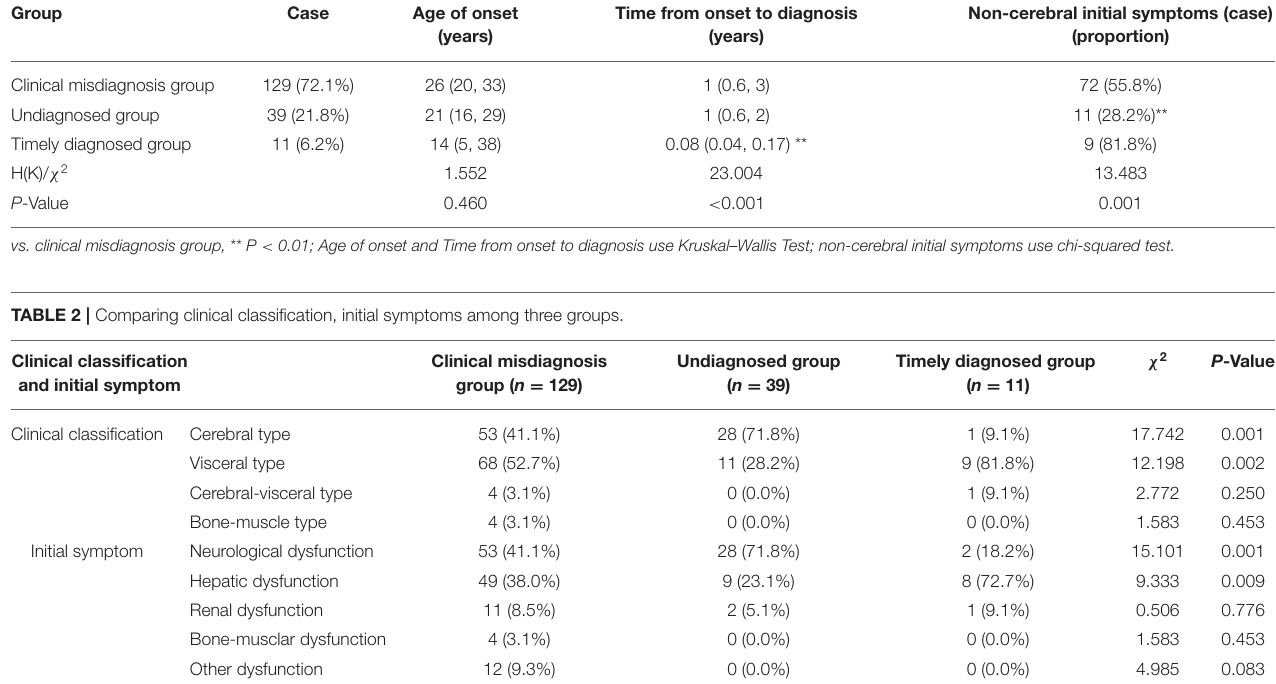
TABLE 1 | Comparing age of onset, time of diagnosis, and initial symptoms among three groups. Group Case Time from onset to diagnosis Clinical misdiagnosis group